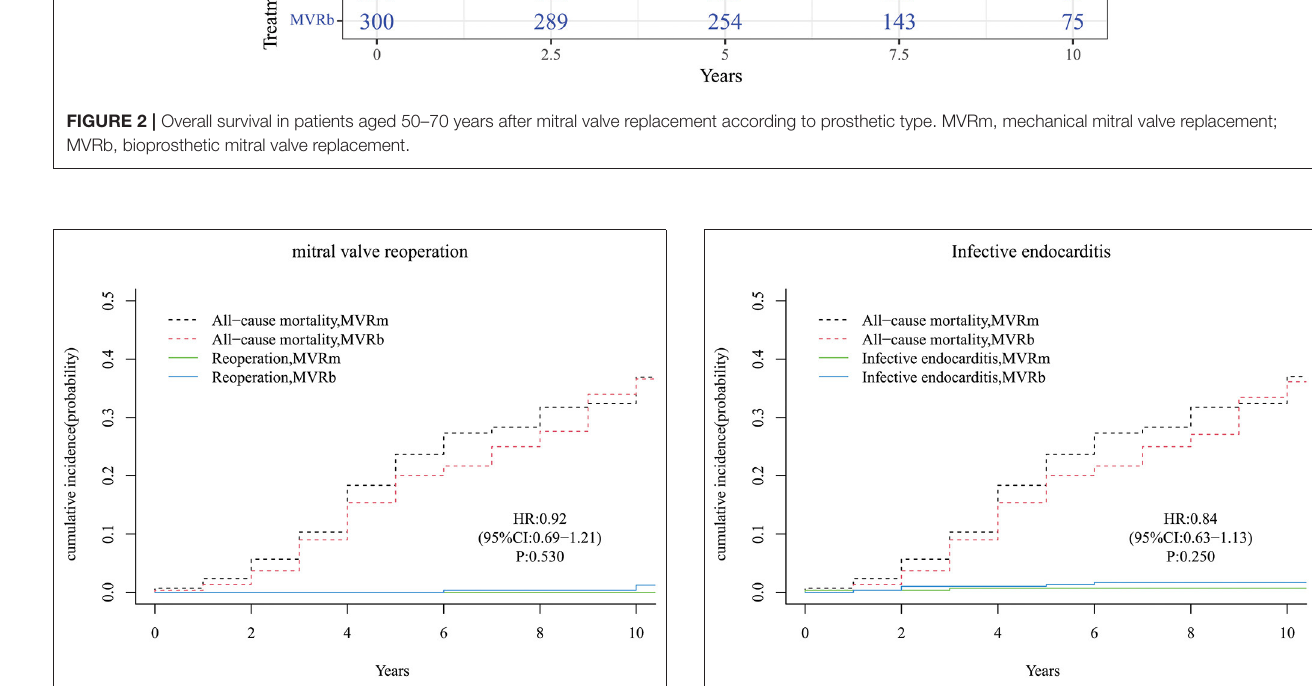
FIGURE 3 | Cumulative incidence of reoperation. MVRm, mechanical mitral valve replacement; MVRb, bioprosthetic mitral valve replacement.